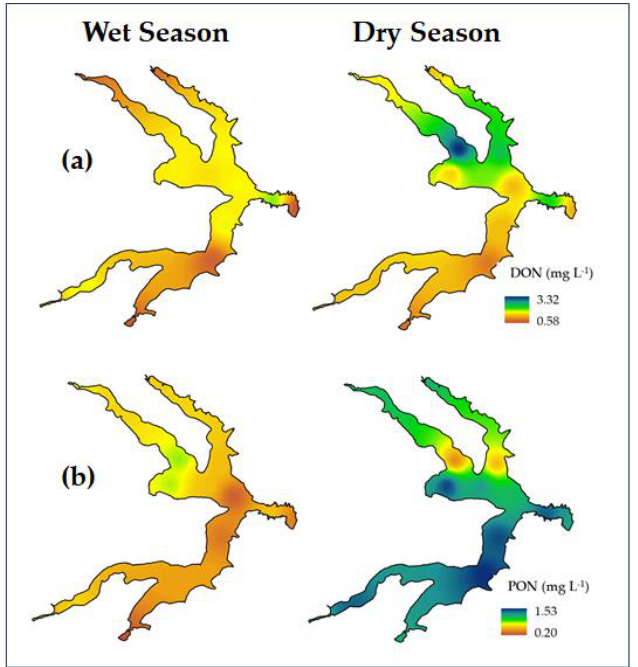
Figure 9. Spatial distribution of water quality variables: ( a ) DON and ( b ) PON for wet and dry season.